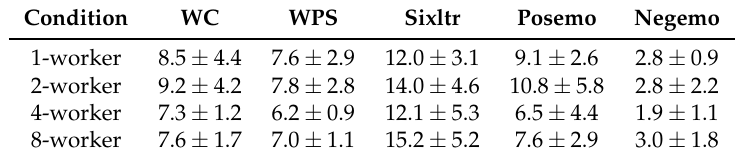
Table 6. Mean scores for five chosen categories calculated through linguistic inquiry and word count (LIWC) tool.